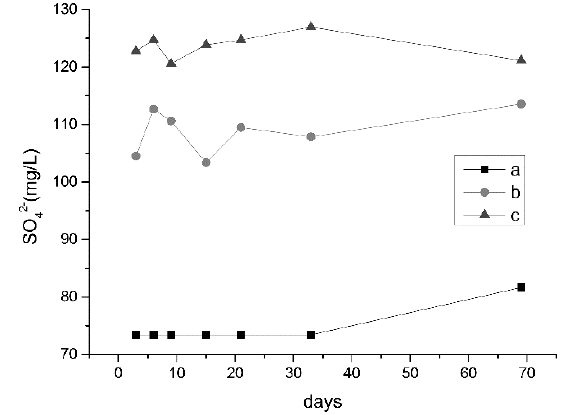
Figure 8. SO 42 − concentration curves of sample liquids (a, b, c, respectively, represent liquids with oil shale heated to 300 °C, oil shale heated to 500 °C, and unheated oil shale).